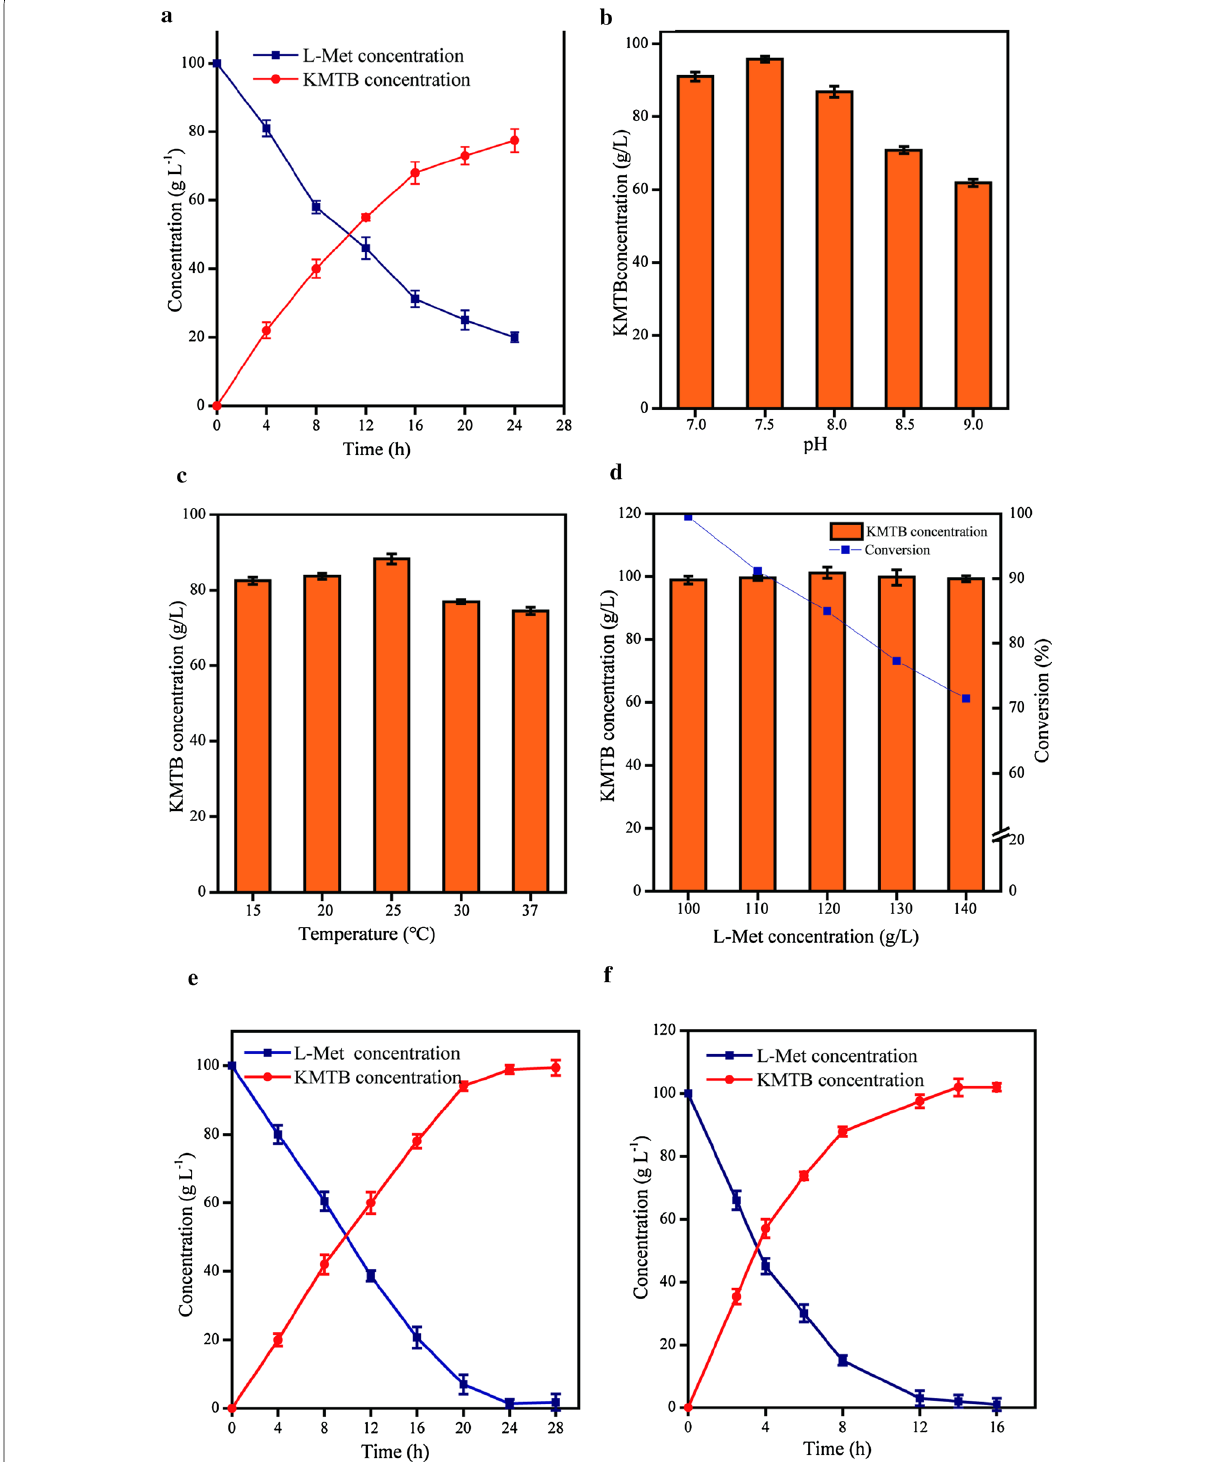
Fig. 2 Optimization of BM. a Time courses of the initial conditions: wet biomass of Pv l -AAD E. coli (20 g L − 1 ) in Tris–HCl buffer (20 mM, pH 8.0) containing the l -methionine (100 g L − 1 ), at 200 rpm and 30 °C. b Effects of different pH on KMTB production. c Effects of different temperatures on KMTB production. d Effects of substrate loading on KMTB production. e Time course of the optimized conditions: wet biomass of Pv - l - AAD E. coli (20 g L − 1 ) in Tris–HCl buffer (20 mM, pH 7.5) containing the l -methionine (100 g L − 1 ), at 200 rpm and 25 °C at 20-mL scale. f Time course of the optimized conditions at 1-L